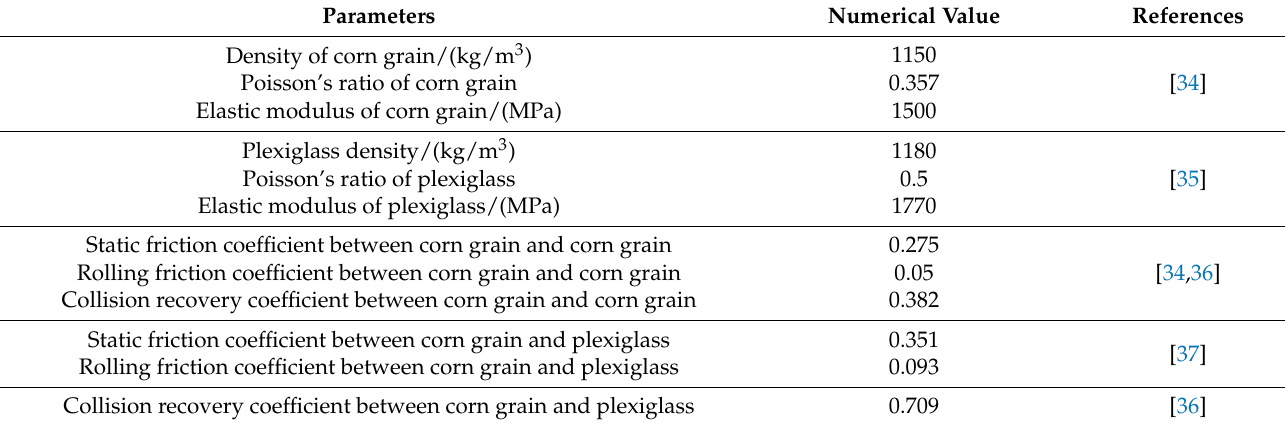
Table 1. Simulation